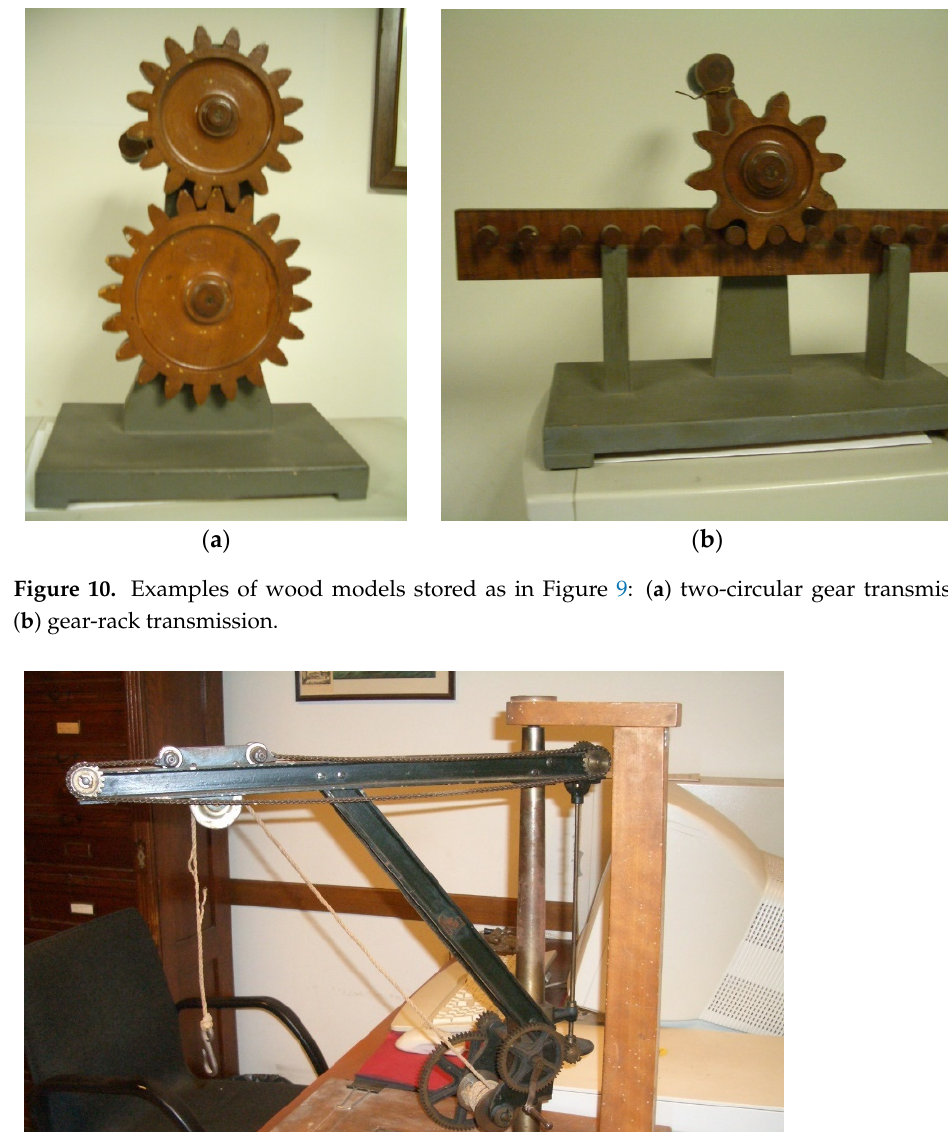
Figure 10. Examples of wood models stored as in Figure 9: ( a ) two-circular gear transmission; ( b ) gear-rack transmission.